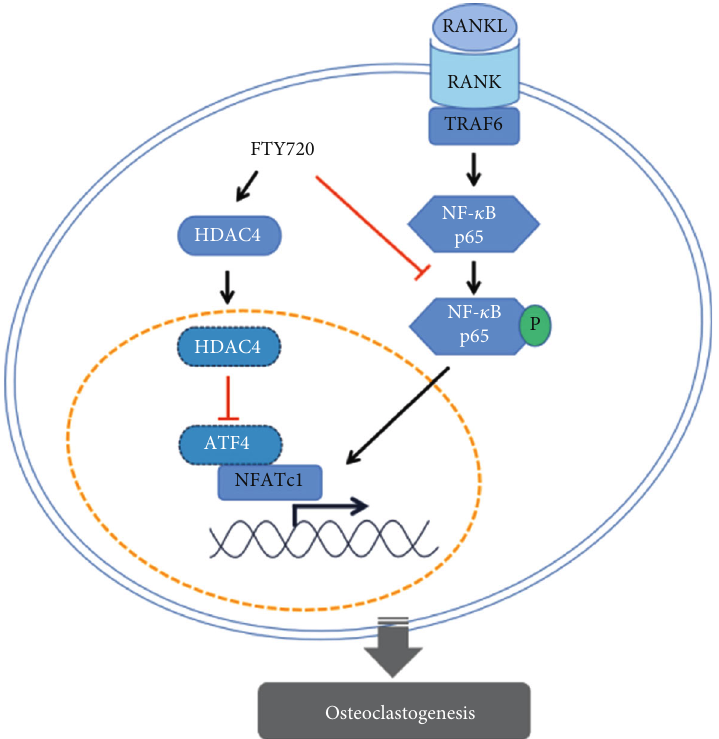
Figure 6: Schematic diagram of the mechanism by which FTY720 inhibits